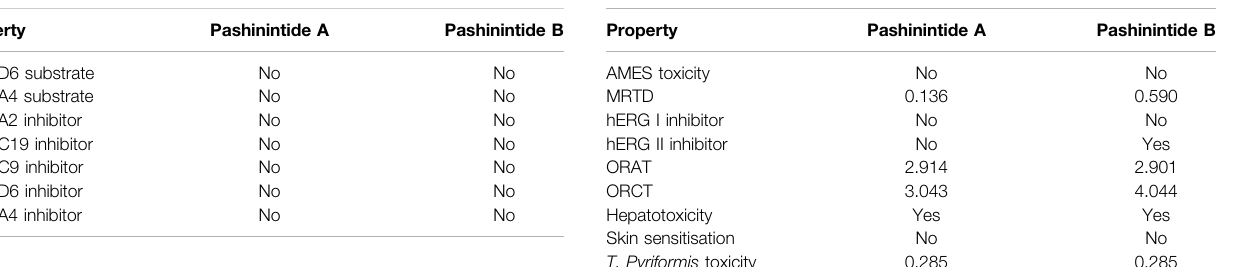
TABLE 8 | Toxicity properties of the Pashinintides A and